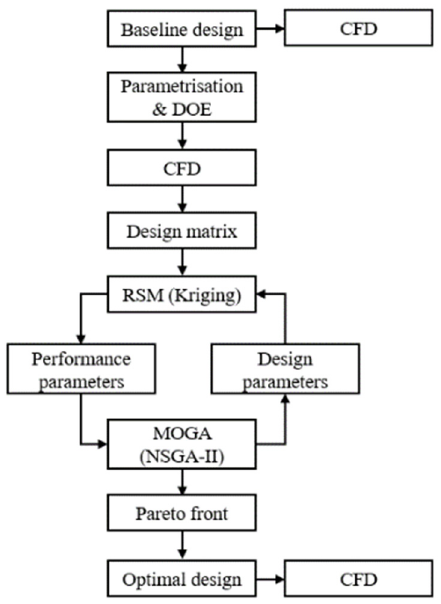
Figure 1. Flow chart of the design and optimization process.